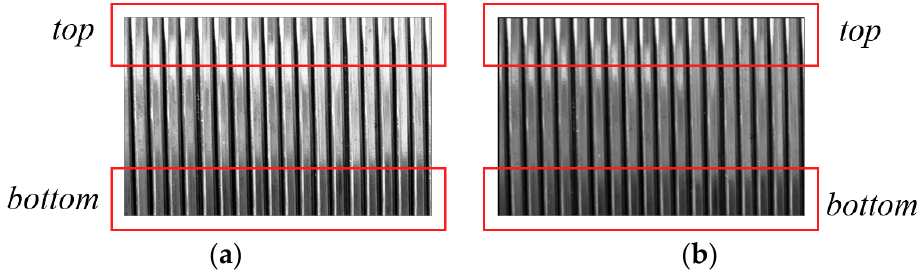
Figure 8. Image graying: ( a ) maximum value method; ( b ) weighted average method. Observing the above images, the grayscale images obtained by the maximum method and the weighted average method have one common feature, the difference in brightness between the two rectangular boxes at the top and bottom of each image is too large, and the follow-up is not conducive to determining the segmentation threshold for binarization. To optimize the grayscale display effect, based on the principle of adaptive histogram equalization, a slicing method is proposed for grayscale equalization of such images with a grayscale difference in this paper, and the method steps mainly